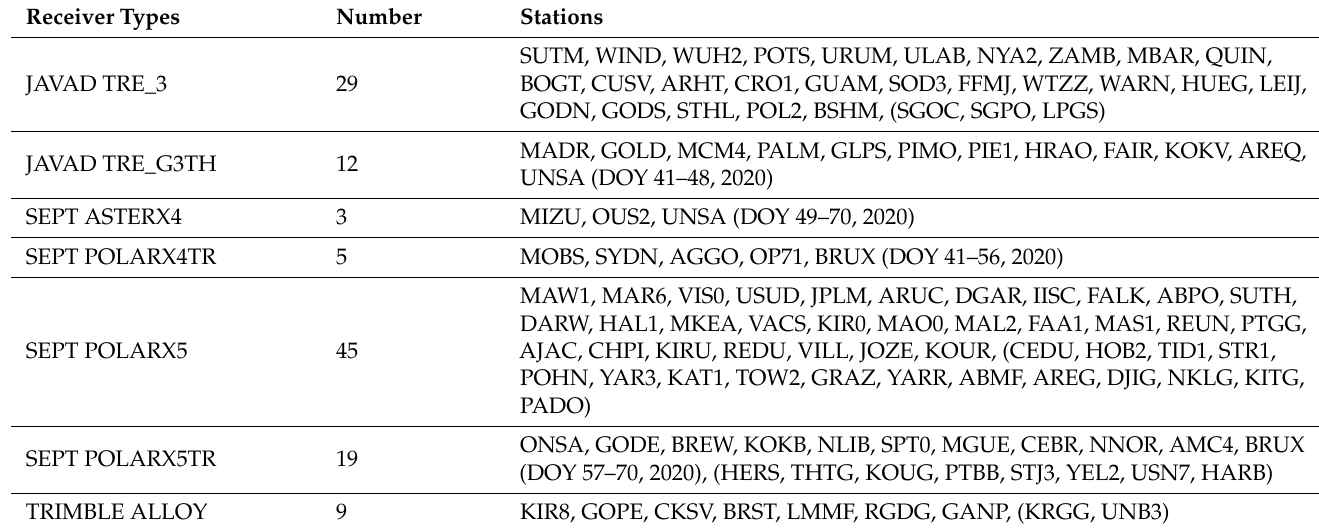
Figure 1. Geographical distribution of the 120 selected MGEX stations. Table 1. Receiver types of the selected stations.